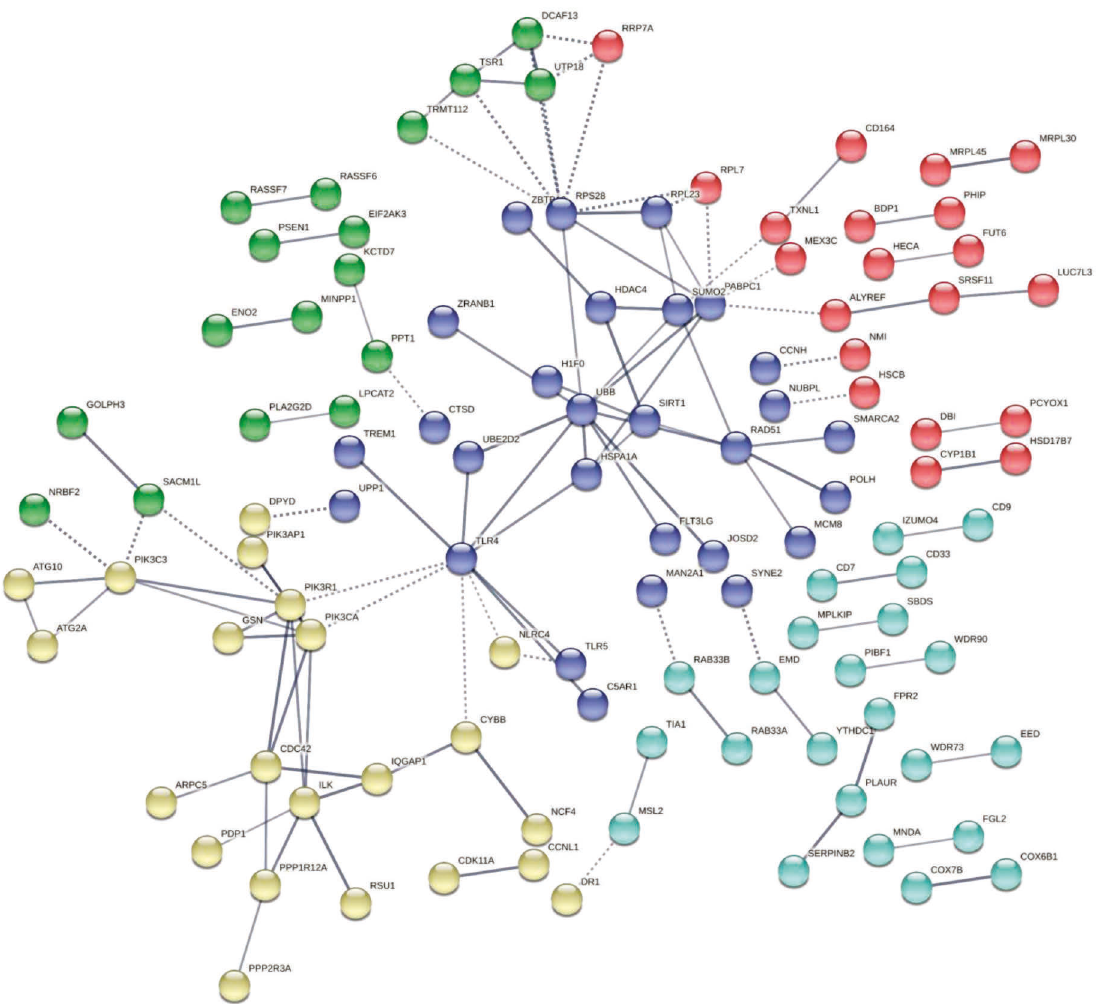
Figure 1: PPI analysis of genes expressed on PBMC of severe COVID-19 patients (Group 1) compared to PBMC of groups with single-dose BCG and naive vaccinated patients (Group 2). The PPI was created using the highest confidence score of